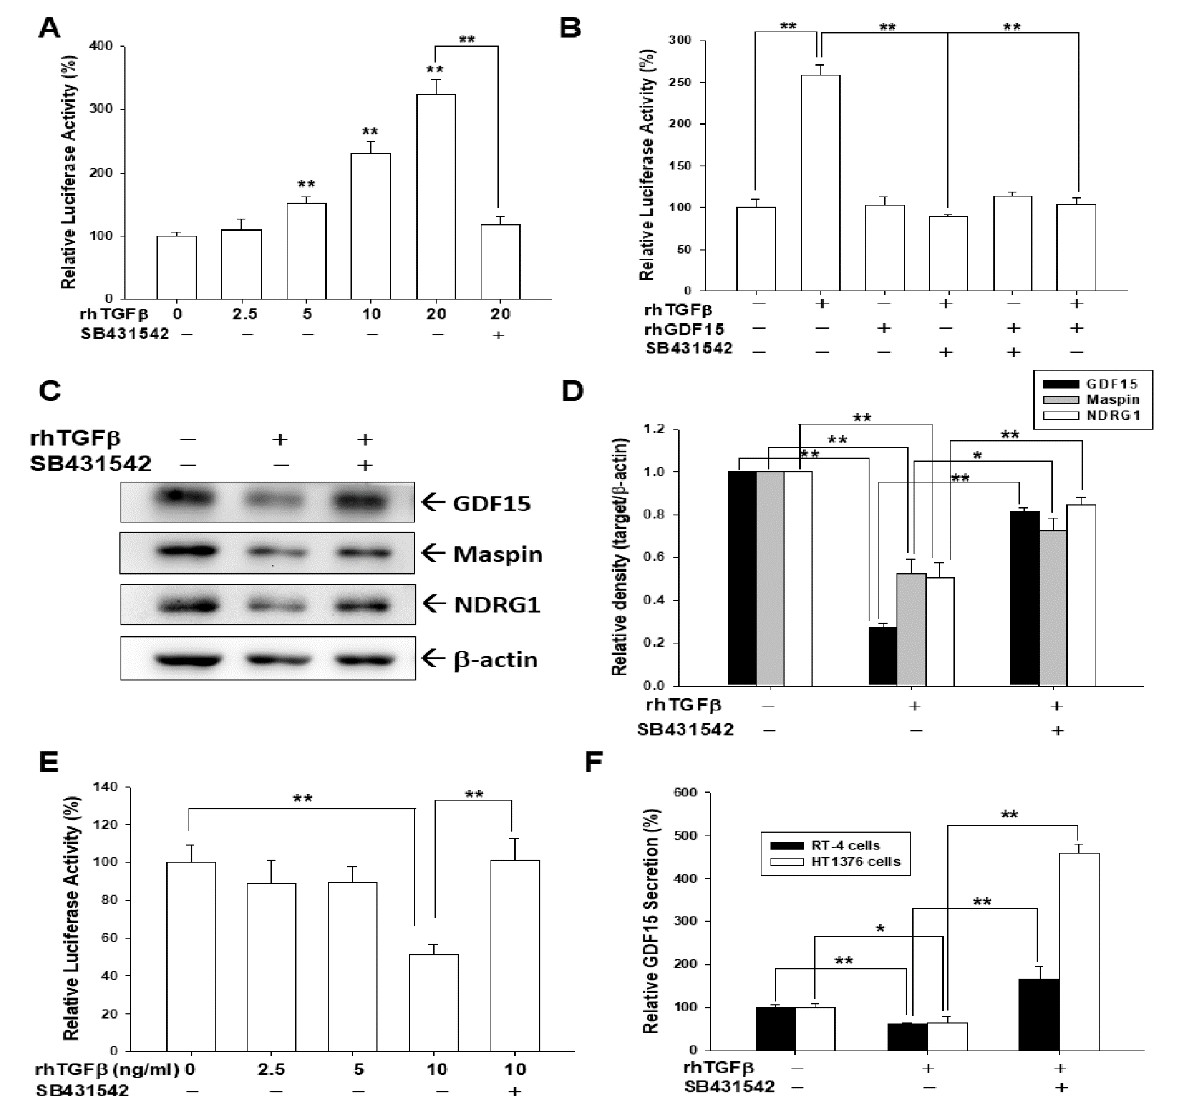
Figure 2. TGF β receptor kinase inhibitor blocked the effect of TGF β on the expressions of GDF15, NDRG1 and maspin in bladder carcinoma cells. The reporter activity of SEB4 reporter vector treated with ( A ) various concentrations of rhTGF β or with 20 μ M SB431542, or ( B ) 10 ng/mL rhTGF β treat- ments with (+) or without ( − ) 400 nM rhGDF15 or 20 μ M SB431542 pretreatment, as indicated, in the HT1376 cells. The expressions of GDF15, maspin, and NDRG1 were determined using immunoblot assays ( C ) and quantitative analysis ( D ) after being treated with (+) or without ( − ) 10 ng/mL rhTGF β and 20 μ M SB431542 for 18 h in HT1376 cells. The quantitative data were expressed as the intensity of protein bands of the target genes/β -actin relative to the control solvent-treated group ( n = 3). ( E ) The reporter activity of the GDF15 reporter vector was treated with various concentrations of rhTGF β or with 20 μ M SB431542 as indicated. Data are expressed as the mean percentage of lucif- erase activity relative to the mock-treated group ( n = 6). ( F ) RT-4 and HT1376 cells were treated with 10 ng/mL rhTGF β with (+) or without (−) 20 μ M SB431542 pretreatment for 24 h. The supernatants of culture media ( n = 4) were collected and GDF15 secretions were determined by ELISA. The data were presented as the mean percentage compared with the control group. * p < 0.05, ** p < 0.01.